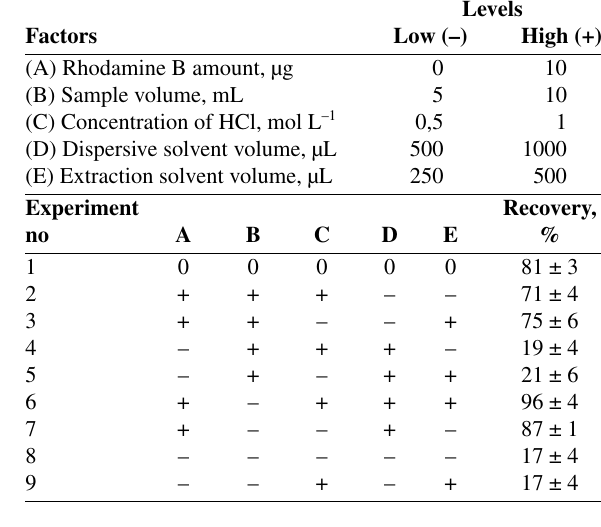
Table 3. The design variables, low and high levels and design ma- trix in Plackett-Burman design